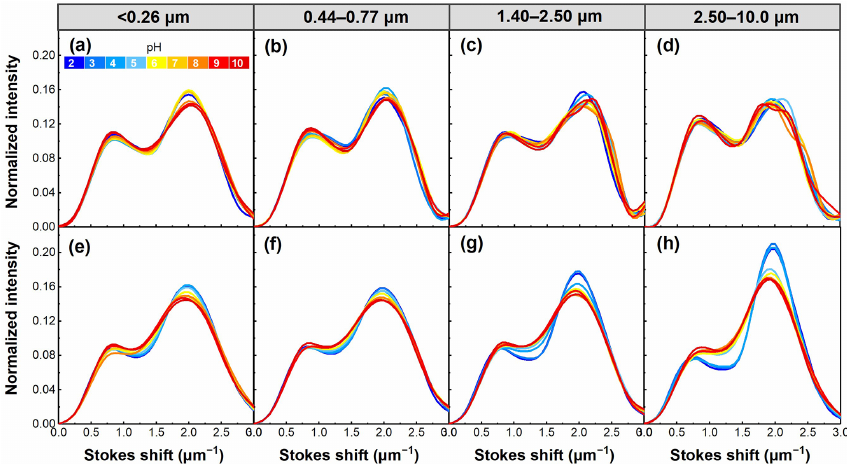
Figure 11. pH dependence of the Stokes shift for WSOC in particles of different sizes in summer (a–d) and winter (e–h) in the pH range of